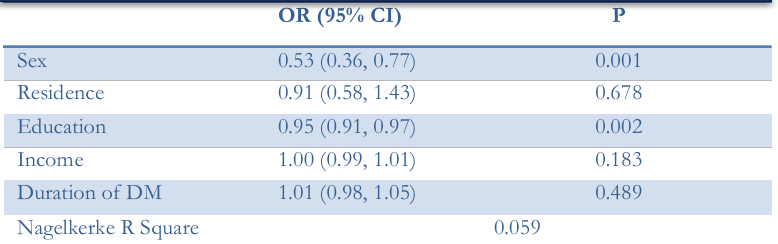
Table 6: Distribution of factors, which are associated with